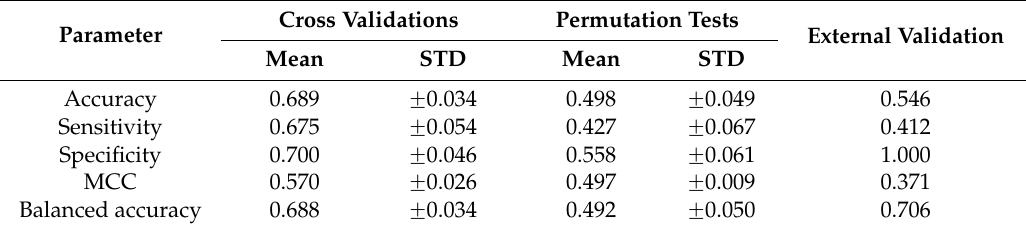
Figure 2. Boxplots for the predictions from the DF models in the 5-fold cross validations. Performance were measured by metrics as indicated on the x -axis. Table 1. Summary of cross validations, permutation tests, and external validation.